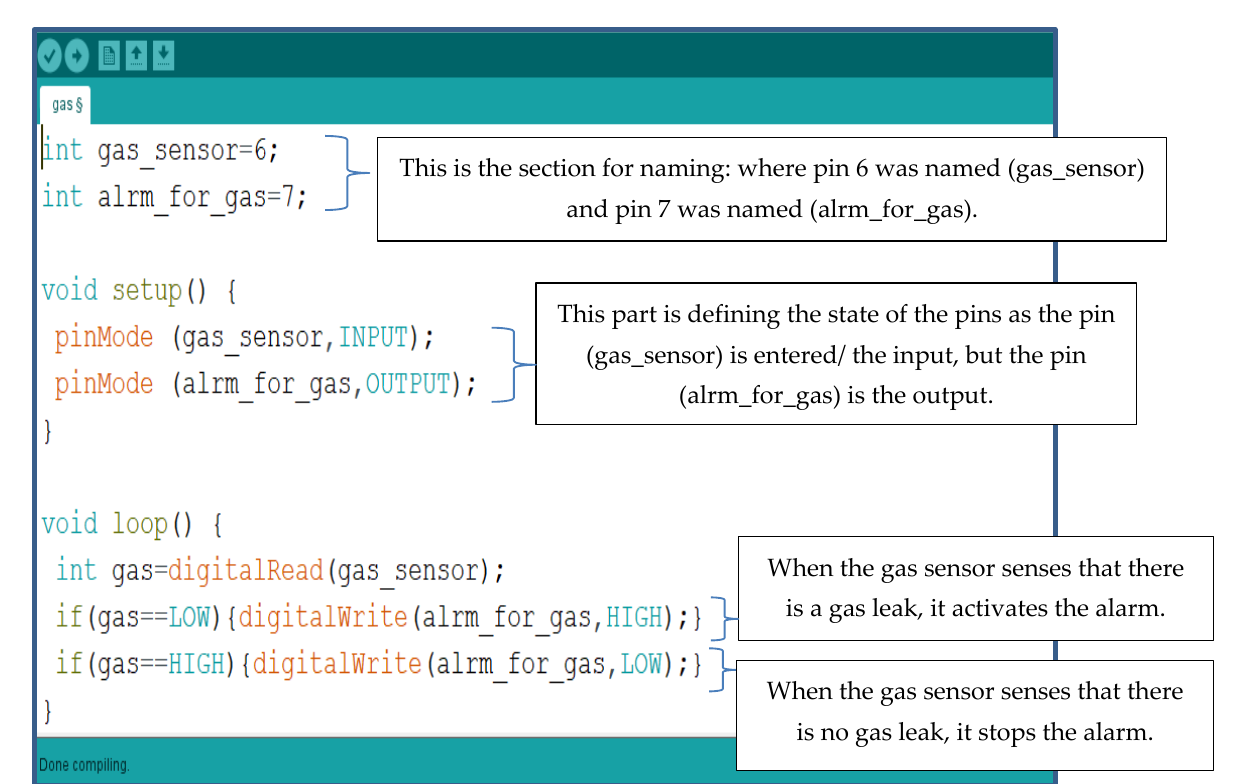
Figure A7. The implemented code for the fire alarm system.